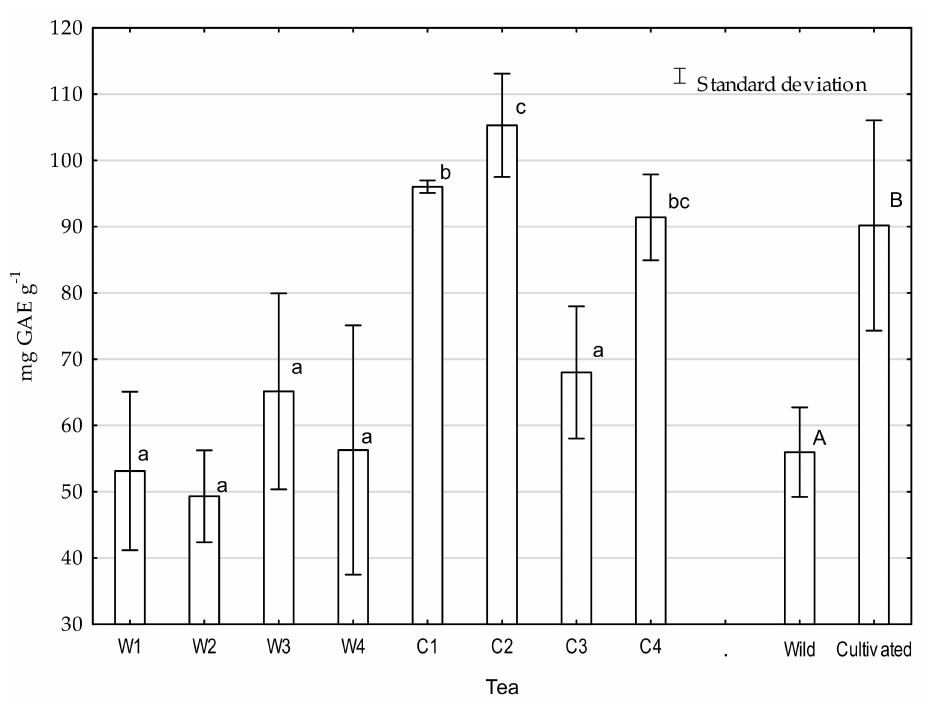
Figure 5. Total phenolic content in tea infusion expressed as mg gallic acid equivalent (GAE) · g − 1 DW. Means with different letters are significantly different, according to Tukey’s test ( p ≤ 0.05).